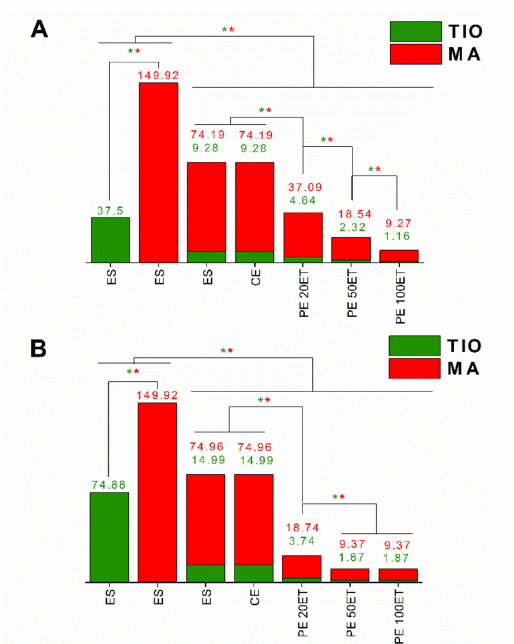
Figure 5. Minimum fungicidal concentration (MFC) of ES-TIO, ES-MA, ES-TIO-MA, CE-TIO-MA, PE 20ET-TIO-MA, PE 50ET-TIO-MA, and PE 100ET-TIO-MA in µ g / mL on T. rubrum ( A ) and C. albicans ( B ). Six independent experiments with three technical replicates were performed. The green ( * ) and red ( * ) asterisks represent a significance value of p < 0.01 for the MFC,